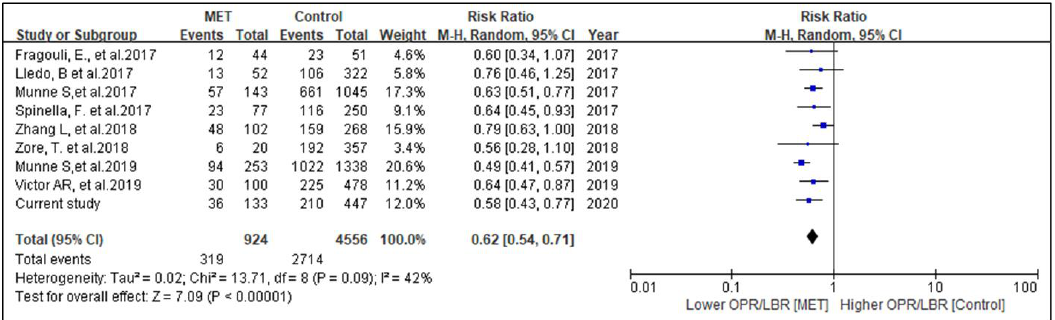
Figure 3. Meta-analysis of the comparison of ongoing pregnancies/live birth rates. Meta-analysis performed by the random effect model due to the fact that p -value of the heterogeneity test was less than 0.1.